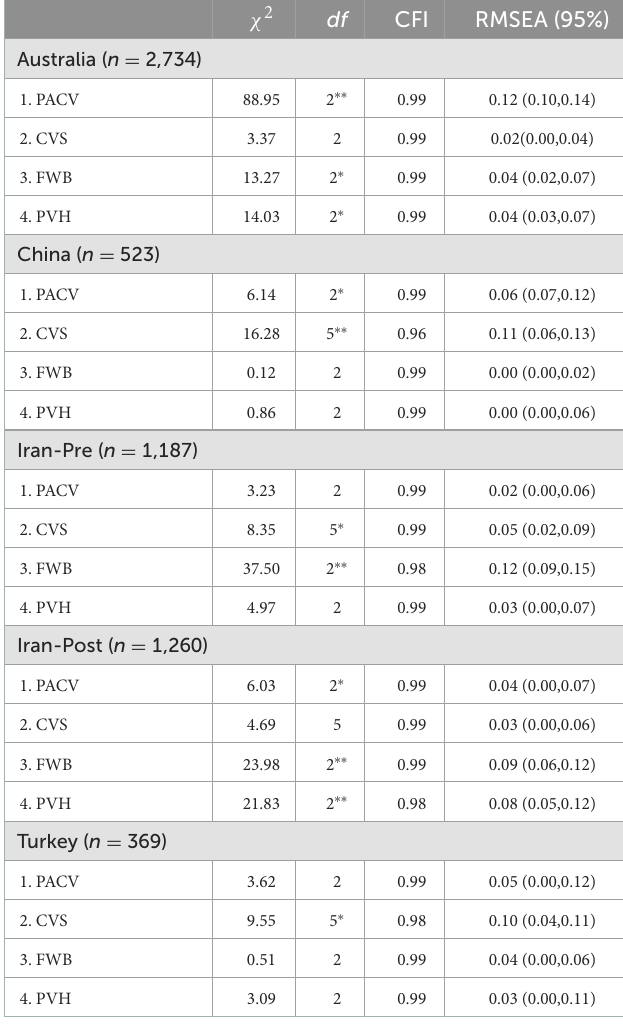
TABLE 3 Correlation results for the study variables.